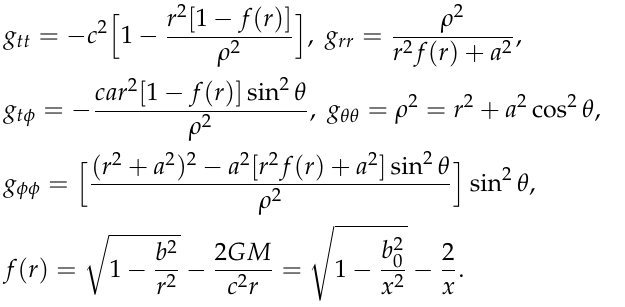
Figure 9. The plot shows the constrained quantum deformed parameter b with 68% and 96% confidence